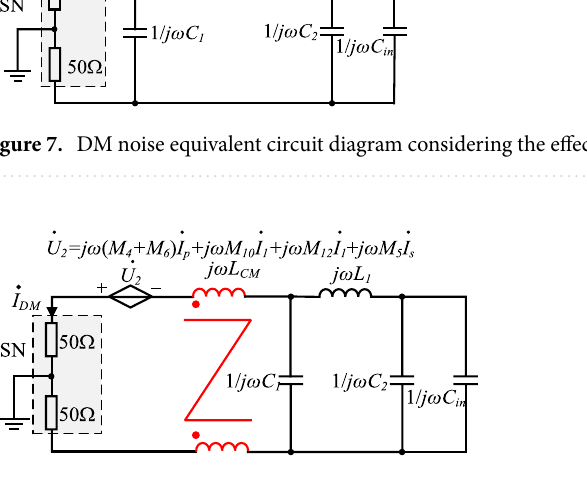
Figure 8. DM noise equivalent circuit diagram considering the effects of near-field coupling on CM choke.